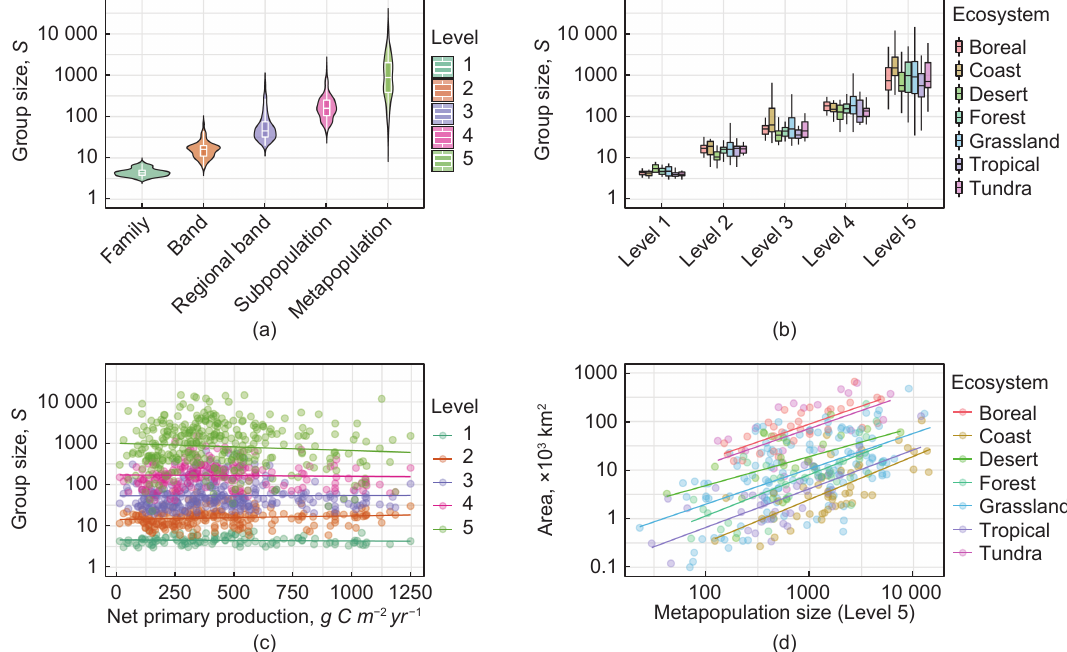
n = 339 Fig. 4 Hierarchically modular structure of hunter-gatherer networks using data from Binford ( ) [70] . (a) Social group sizes at five levels of social organization for 339 populations show a geometric series. (b) The same social group size data at each of the five levels plotted by the ecosystem of the population, showing the geometric increase in group size holds across habitats. For statistical results, see Table 4 in the following. (c) Social group size at each level plotted as a function of the net primary production of the environment for each population, showing that the variation in group size within each level is independent of environmental productivity. For statistical details see Table 5 in the following. (d) Hunter-gatherer territory size plotted as a function of total population size (Level 5), plotted by ecosystem type for each population. Across ecosystems hunter-gatherer populations are structured by self-similar networks, and exhibit economies of scale in space-use where larger networks. For statistical results, see Table 6 in the